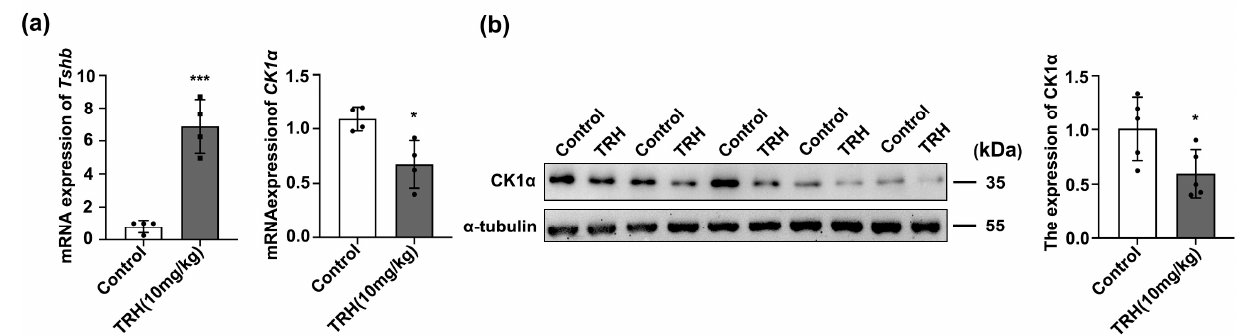
Figure 4. TRH reduces CK1 α expression. ( a ) Pituitary tissue Tshb mRNA expression was quanti fi ed using RT-PCR after 1 h of TRH injection. Gapdh was used as an internal control. * p < 0.05 and *** p < 0.001; n = 3. ( b ) Western blo tt ing was used to verify the expression of CK1 α . The protein bands were normalized to that of α -tubulin. * p < 0.05 , n = 5.